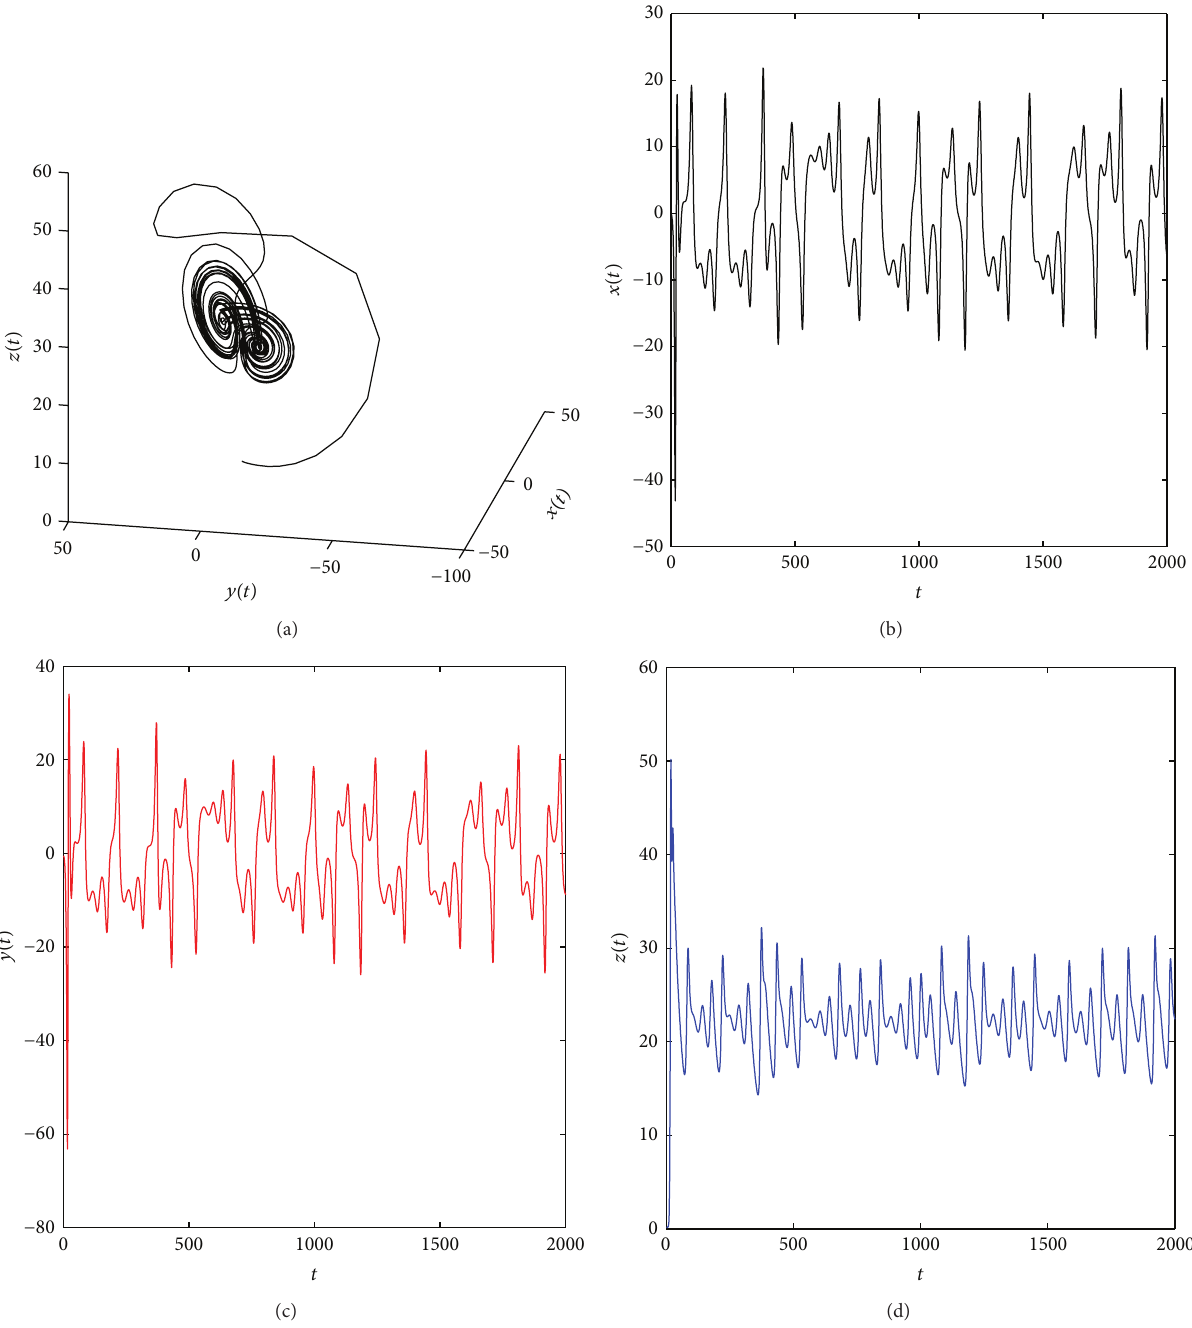
Figure 5: Chaotic attractor of the distributed order fractional Chen system (22) with ( 𝑞 11 , 𝑞 12 , 𝑞 21 , 𝑞 22 , 𝑞 31 ,𝑞 32 ) = (0.85, 0.3, 0.85, 0.3, 0.85, 0.3) and (𝑎,𝑏, 𝑐) = (35, 3, 29)